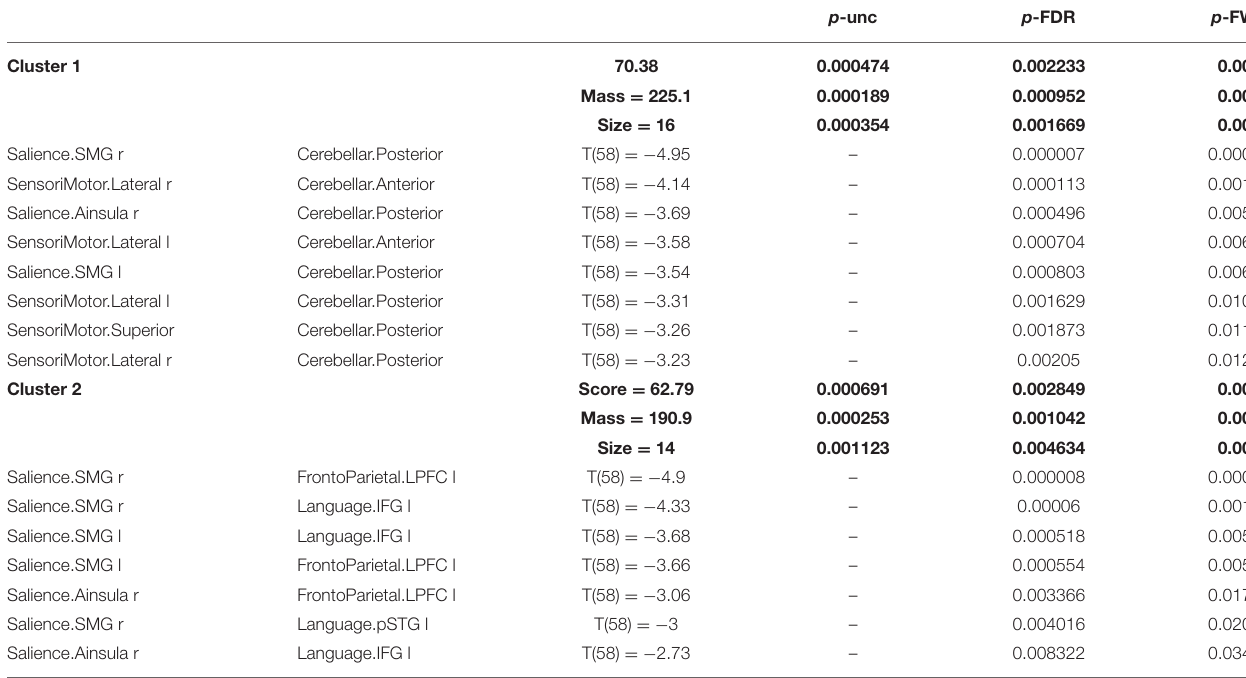
TABLE 3 | Statistical cluster analysis of the networks using spatial pairwise clustering (SPC) showing decreased connectivity between